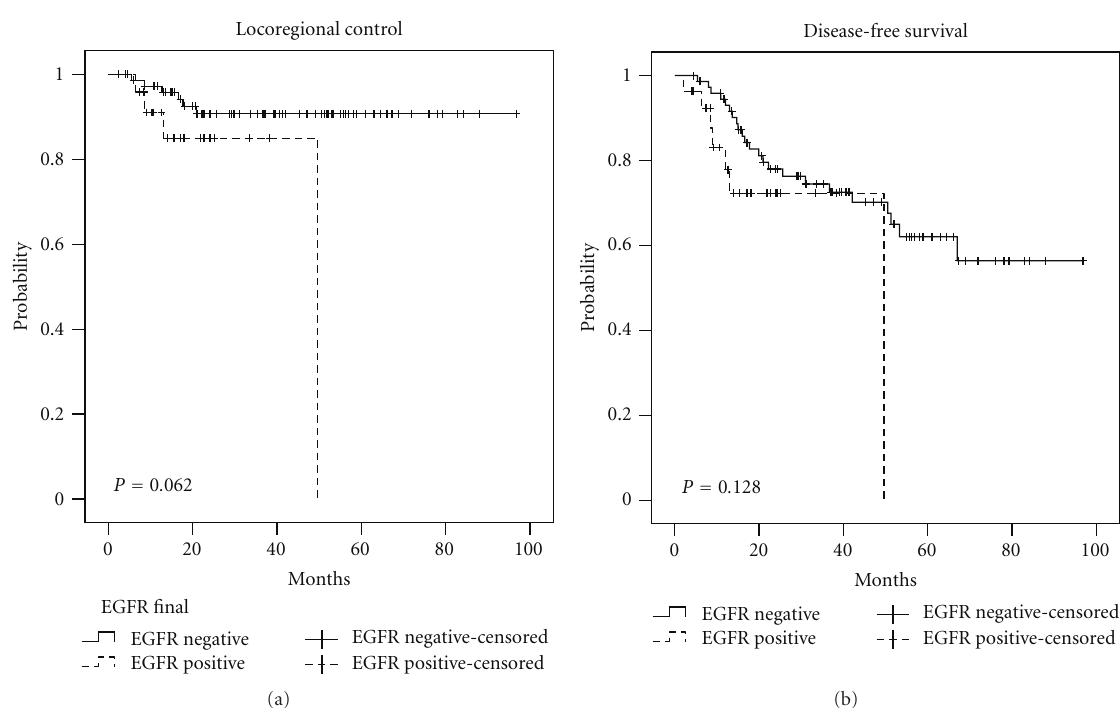
Figure 2: Locoregional control and disease-free survival stratified by EGFR